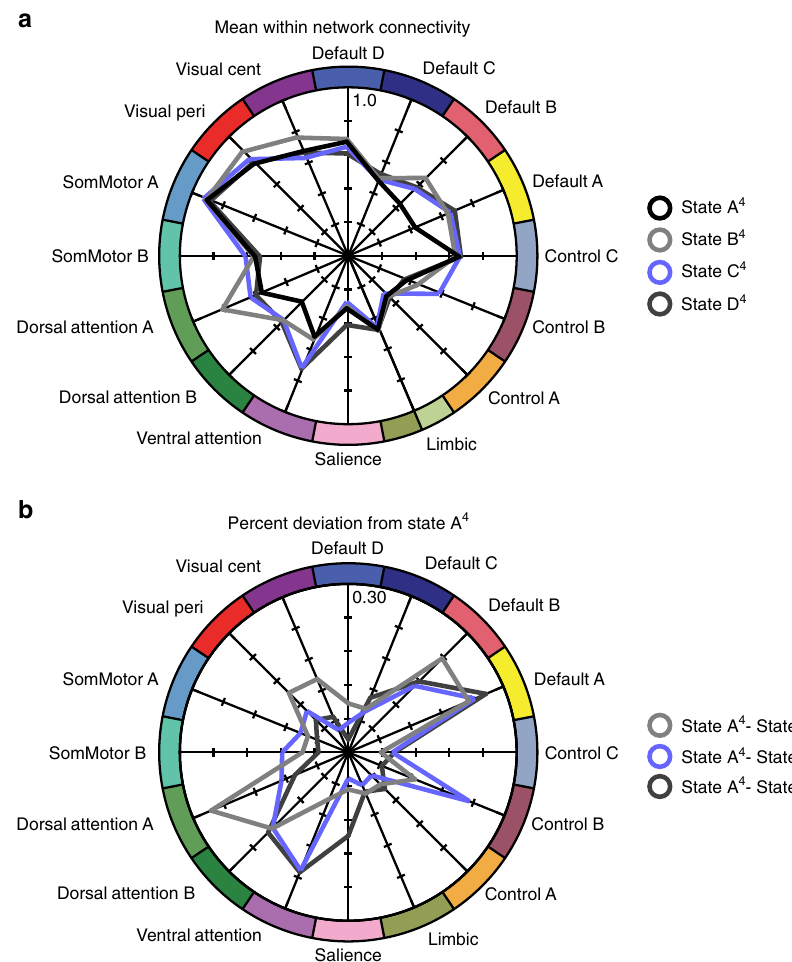
Fig. 4 Pro fi les of within-network connectivity across the four-state solution. a The mean within-network connectivity is shown across each state of the four-state solution ( n = 1919). Values re fl ect z-transformed Pearson correlations. b Percent deviation from state A 4 . Values re fl ect the percent change in mean network connectivity of states B 4 – D 4 , relative to state A